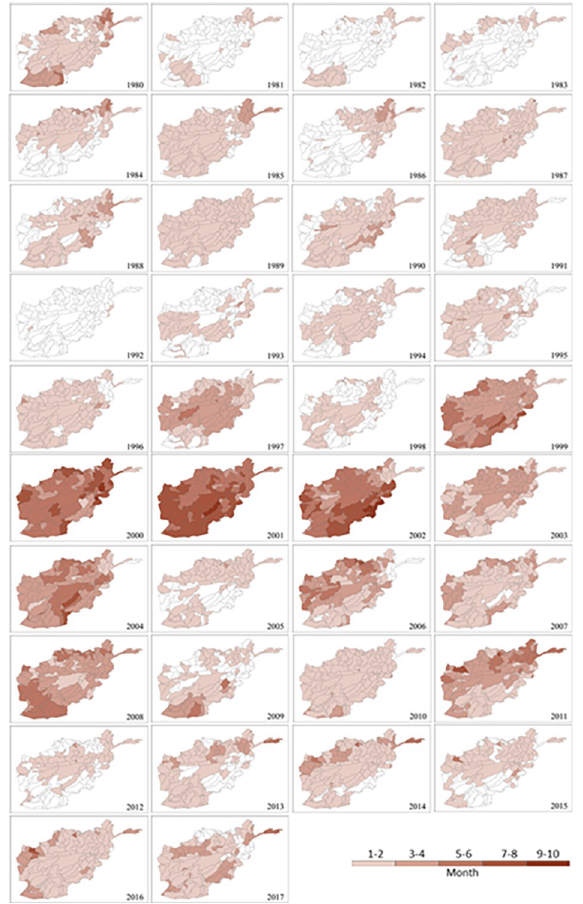
Fig 6. Spatial distribution of mean annual drought frequency at sub-catchment scale in Afghanistan for each year between 1980 and 2017 based on SPEI-1 (monthly scale).